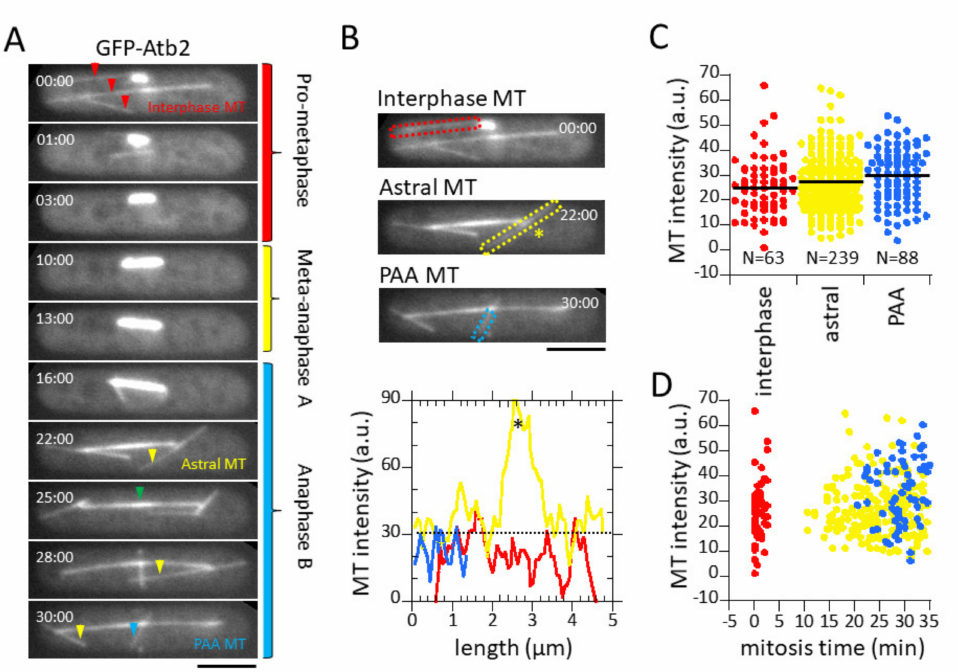
Figure 2. MT fluorescent intensity converts to MT number. ( A ) Shown is a time-lapse summation montage of a wild-type mitotic fission yeast cell expressing GFP-Atb2. Different microtubule structures emerged at different phases of the cell cycle. Interphase MTs (red arrow) begin to depolymerize at the start of mitosis. Prop-metaphase corresponds to the initial spindle formation where the spindle elongates to about ~3 µ m long. Metaphase-anaphase A is where spindle length remains relatively unchanged. Anaphase B is where the spindle elongates to ~12 µ m long then undergoes a breakdown. Early anaphase B marks the emergence of the astral MTs (yellow arrow) and late anaphase B marks the emergence of the PAA MTs (blue arrow). A clear central spindle region, or midzone, is evident during anaphase (green arrow). Note that while the spindle intensity changes throughout mitosis, the intensities of the interphase, astral, and PAA MTs remains relatively the same during the 30 min of imaging. Bar, 5 µ m. ( B ) Plot showing line scans of the interphase, astral, and PAA MT bundles from the cell in Figure 2A. Note that the signal varies for each class of MTs, but all MTs have similar signal intensities. The asterisk * denotes the antiparallel MT overlap of the astral MT bundle. This overlap has 3 × higher intensity compared to the distal MT regions. ( C ) Dot plot of fluorescence intensities of interphase, astral, and PAA microtubules. The three different MT structures have similar mean intensities of ~30 a.u. ( D ) Dot plot of fluorescence intensities of interphase, astral, and PAA microtubules versus mitosis time. The three different MT structures have similar mean intensity over the entire imaging